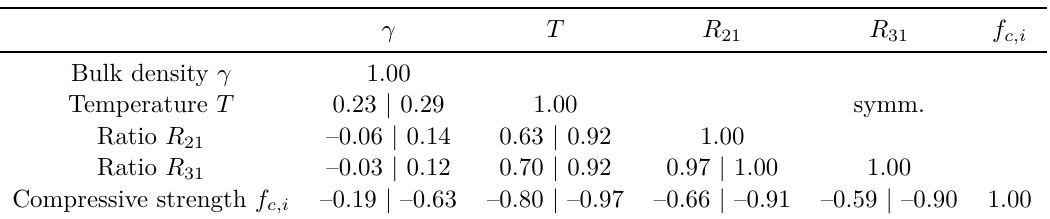
Table 3. Coefficients of correlation (dimensionless) of selected data: all values (Table 1) | mean values (Table 2). –0.97 to –0.80) was confirmed in this